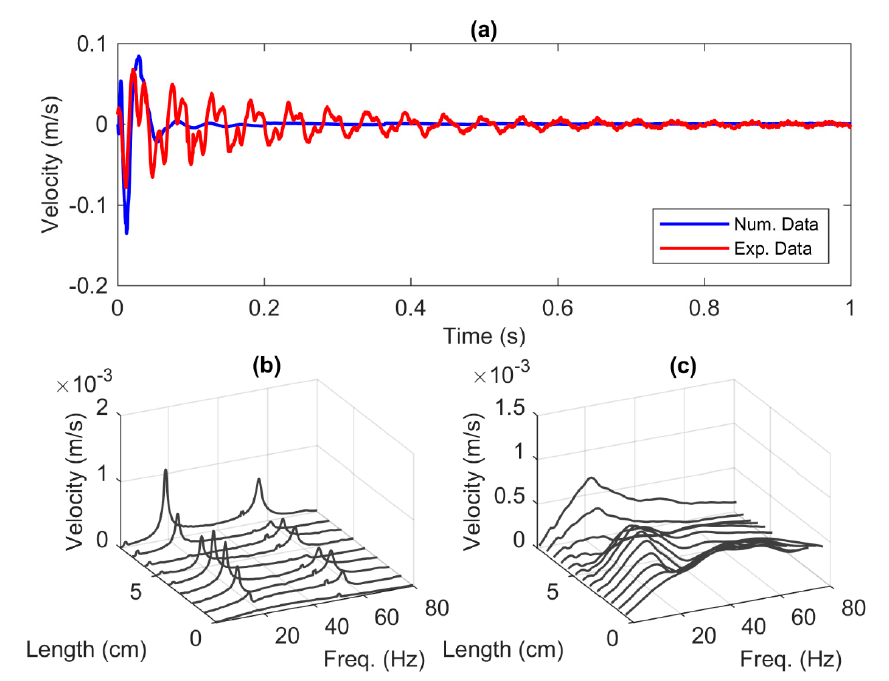
Figure 11. ( a ) The time series of velocity at x = 8 cm and the frequency series of ( b ) the experimental model and ( c ) the numerical model.